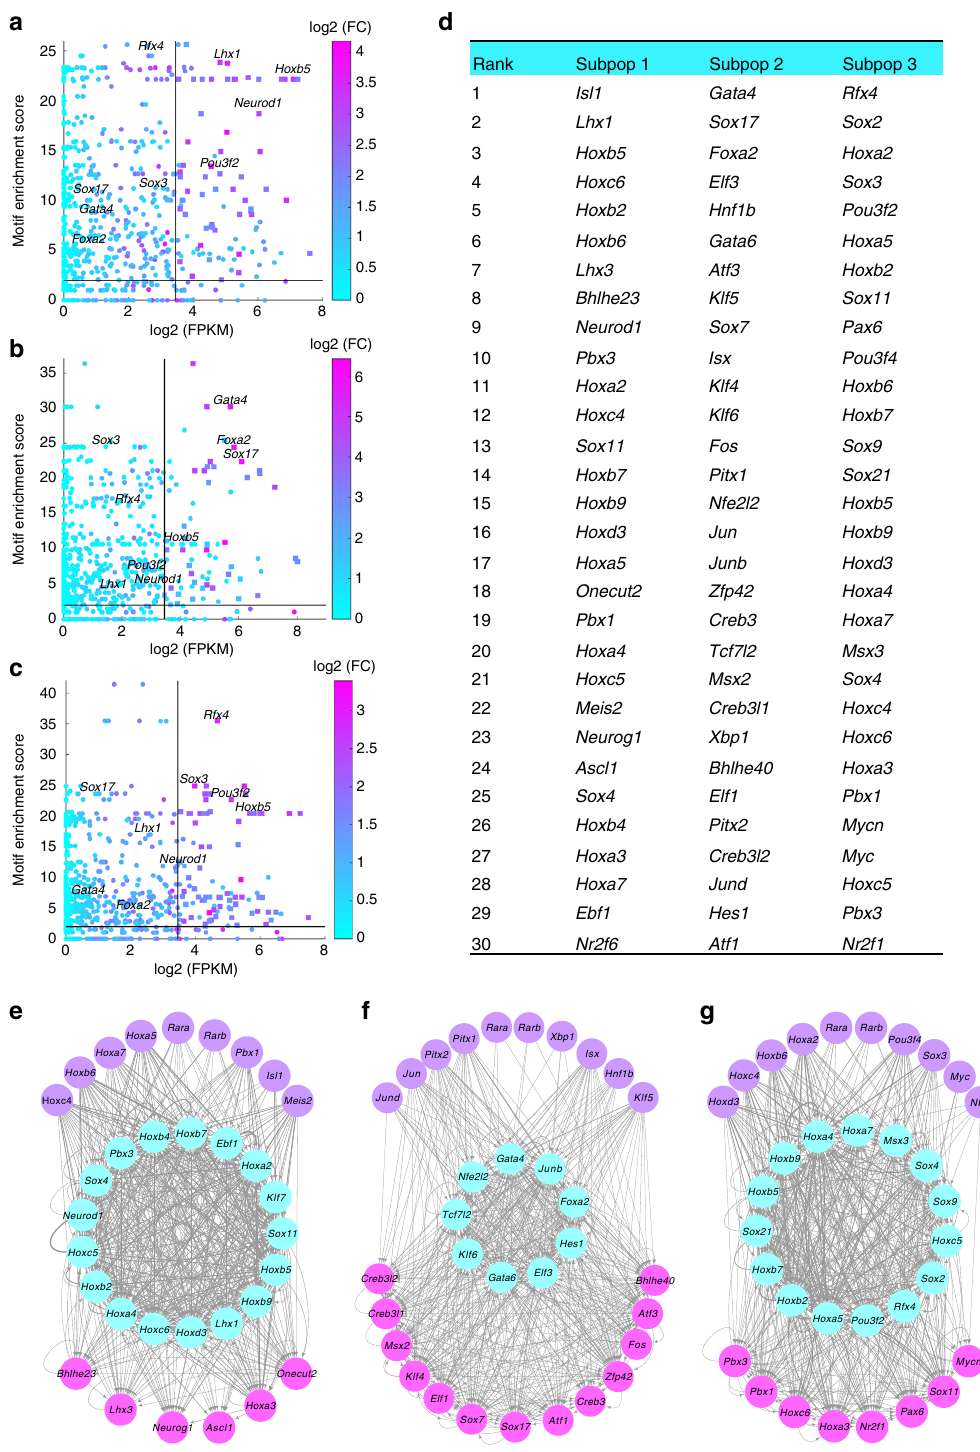
Fig. 3 Analysis of subpopulation-speci fi c regulatory networks. a – c Scatter plots of TF expression level and motif enrichment scores in the three subpopulations in RA-day 4. Node color represents expression speci fi city. Horizontal and vertical black lines indicate threshold values of motif enrichment scores and TF expression level. Key TFs are represented by squares (see text for key TF de fi nition). d Top 30 key TFs in each subpopulation. Ranking is based on the product of log2(FPKM), motif enrichment score and expression speci fi city. e – g Dense subnetworks of key TFs plus expressed RA receptors in subpopulations 1 to 3 (left to right). Cadet blue color nodes represent the core subnetwork, violet nodes represent the upstream subnetwork and pink nodes represent the downstream subnetwork. Only the top 30 key TFs are shown. Source data are provided as a Source Data fi